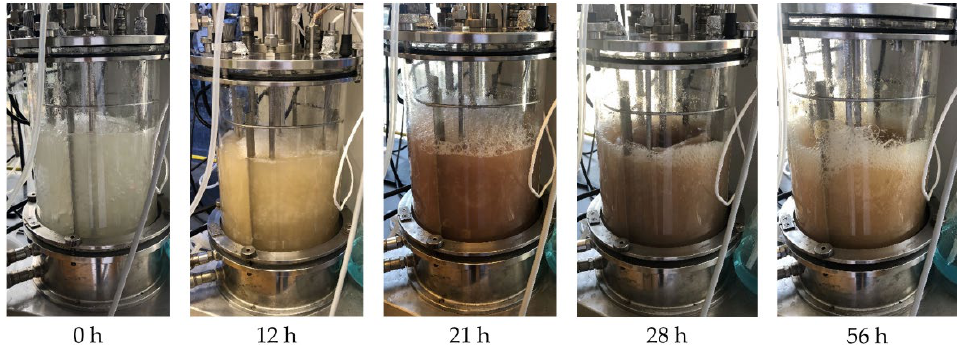
Figure A10. Pictures of culture #3 at different times of the fermentation process.